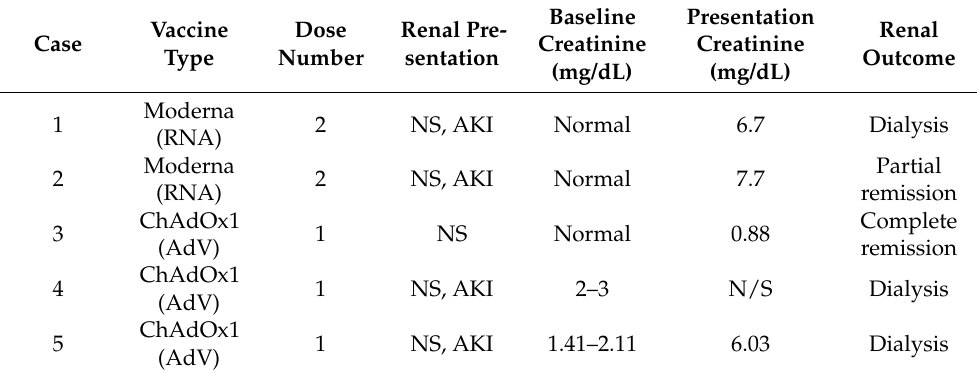
Table 2. Cases of Collapsing Glomerulonephritis following SARS-CoV-2 vaccination. Presentation.